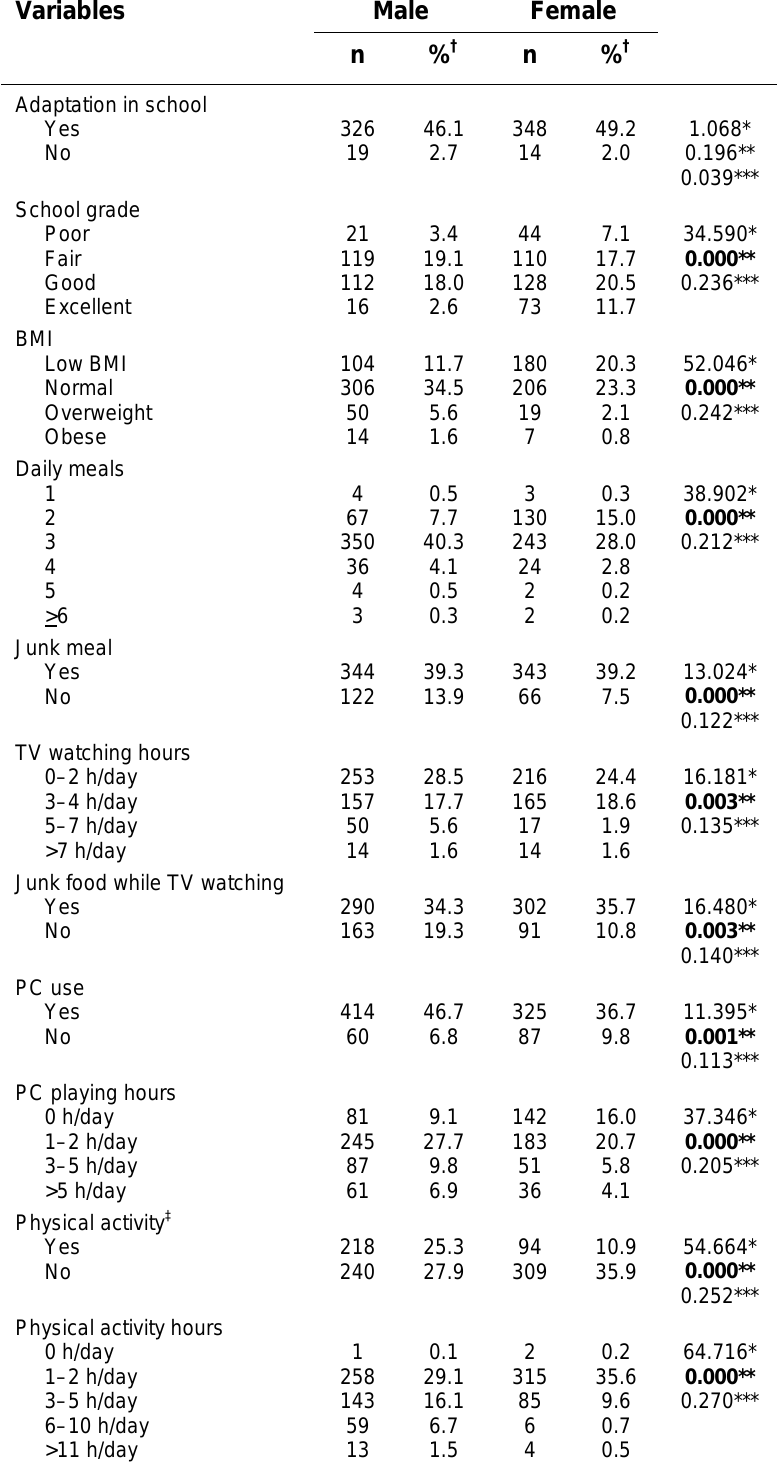
Comparison of Variables According to Gender